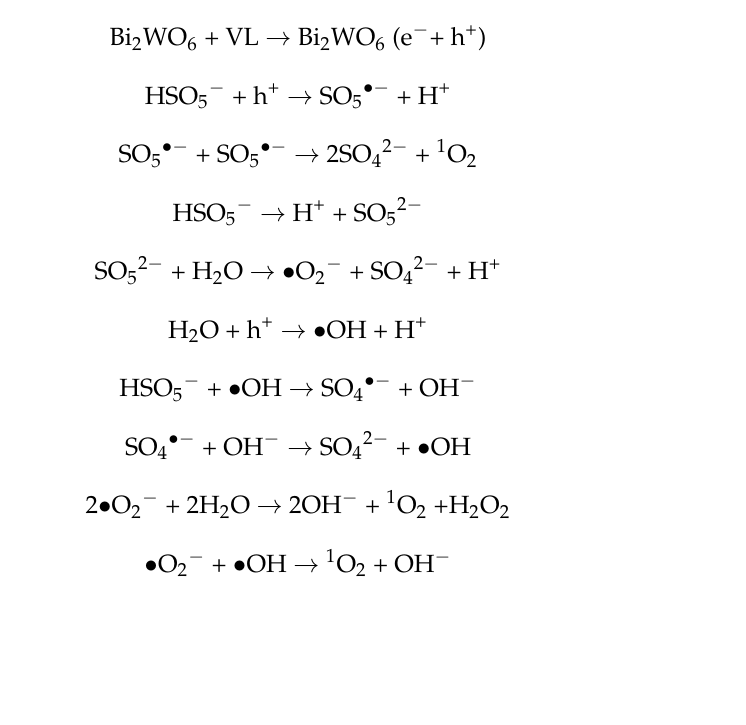
Figure 6. ( a ) Acute toxicity, ( b ) bioconcentration factor, ( c ) developmental toxicity, and ( d ) mutagenicity of CBZ and degradation intermediates.